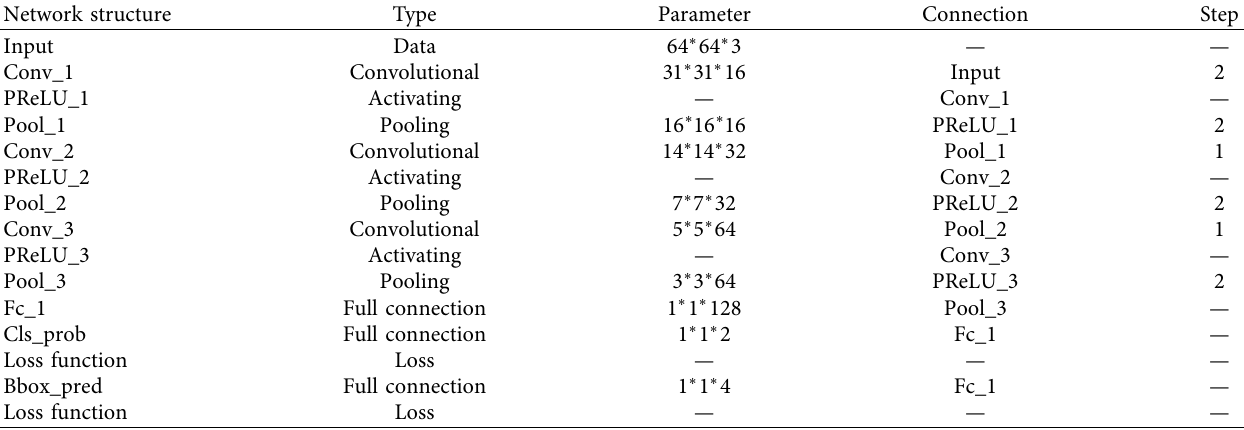
Table 1: Design of convolution neural network model.